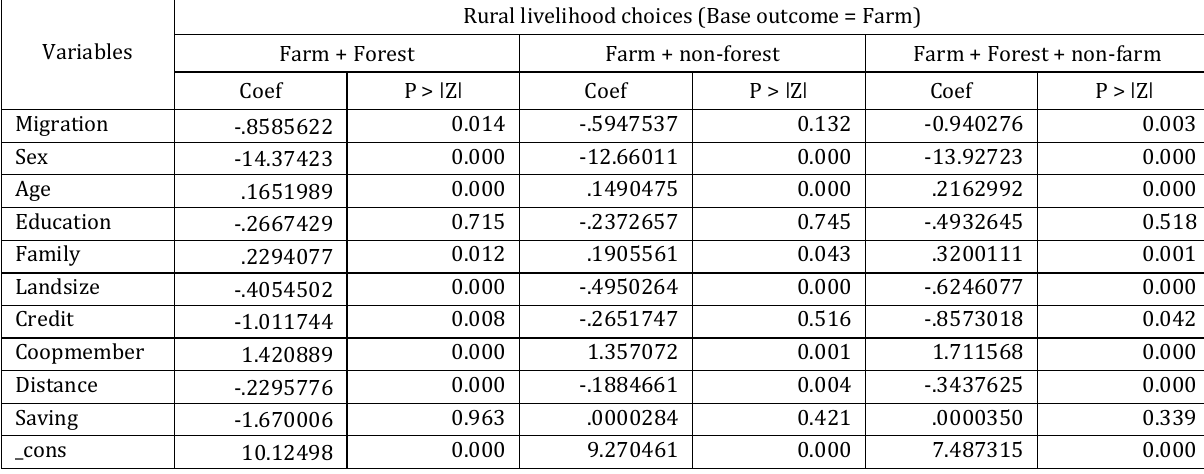
Table 5. Multinomial logit model estimation of households’ livelihood choice Rural livelihood choices (Base outcome = Variables